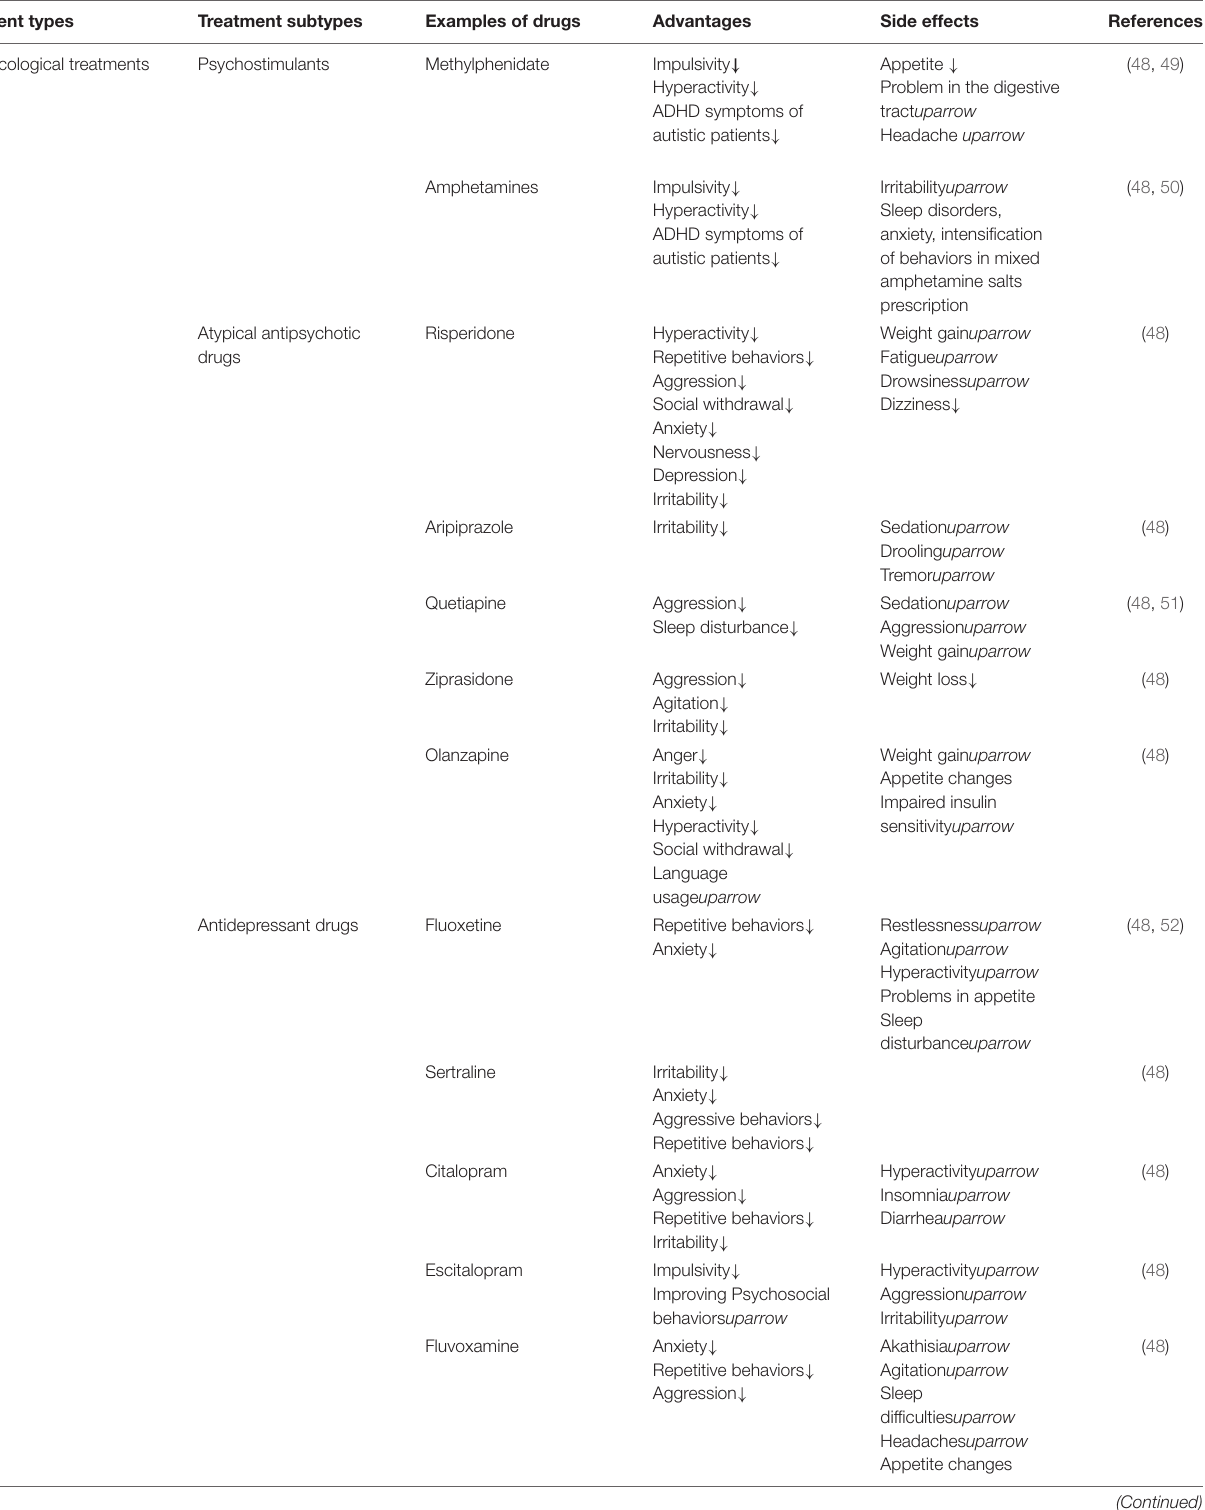
TABLE 1 | Current therapeutic approaches for ASD